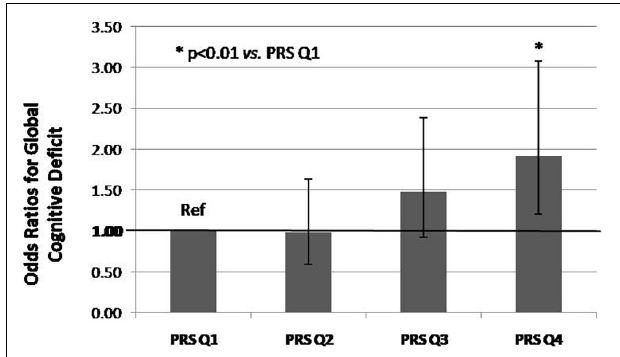
FIGURE 3 | Odd ratios for PD prodromal marker Global Cognitive Deficit by PRS quartile (Q), com-pared to lower quartile in older population ( n = 1,120). P -values derived from logistic regression models adjusted for MDSC1, MDSC2, age and sex. P for trend = 0.002. Q4 vs. Q1: OR = 1.923, 95%CI: 1.202–3.076, p =